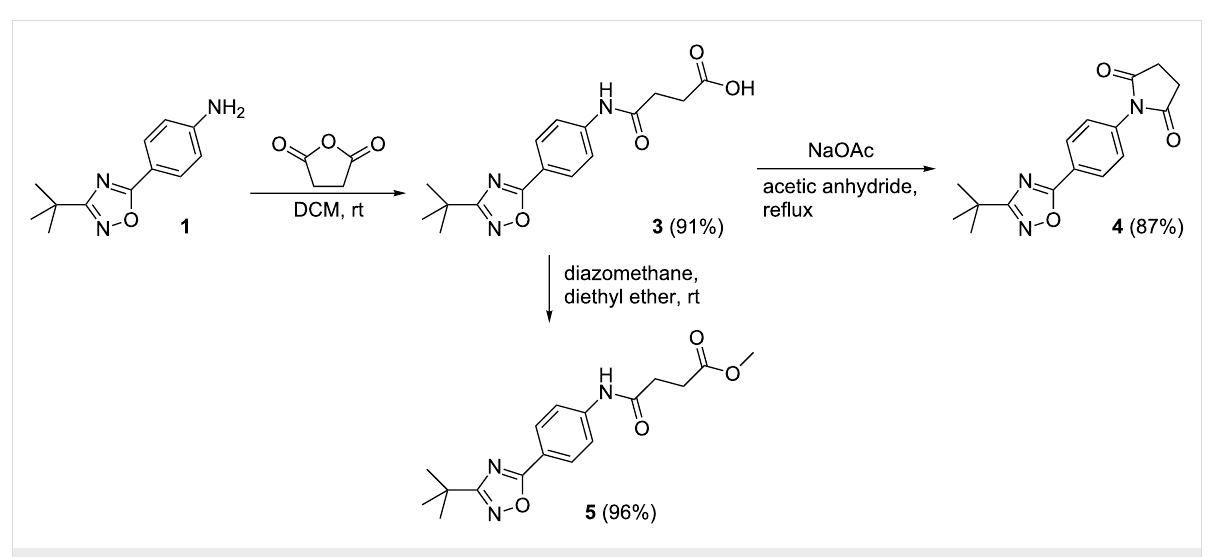
Imide derivatives have been found to possess a broad spectrum of biological activities. A variety of methods have been reported for the preparation of this class of compounds. The synthesis follows a two-step protocol. First, it is necessary to synthesize the amide derivative.